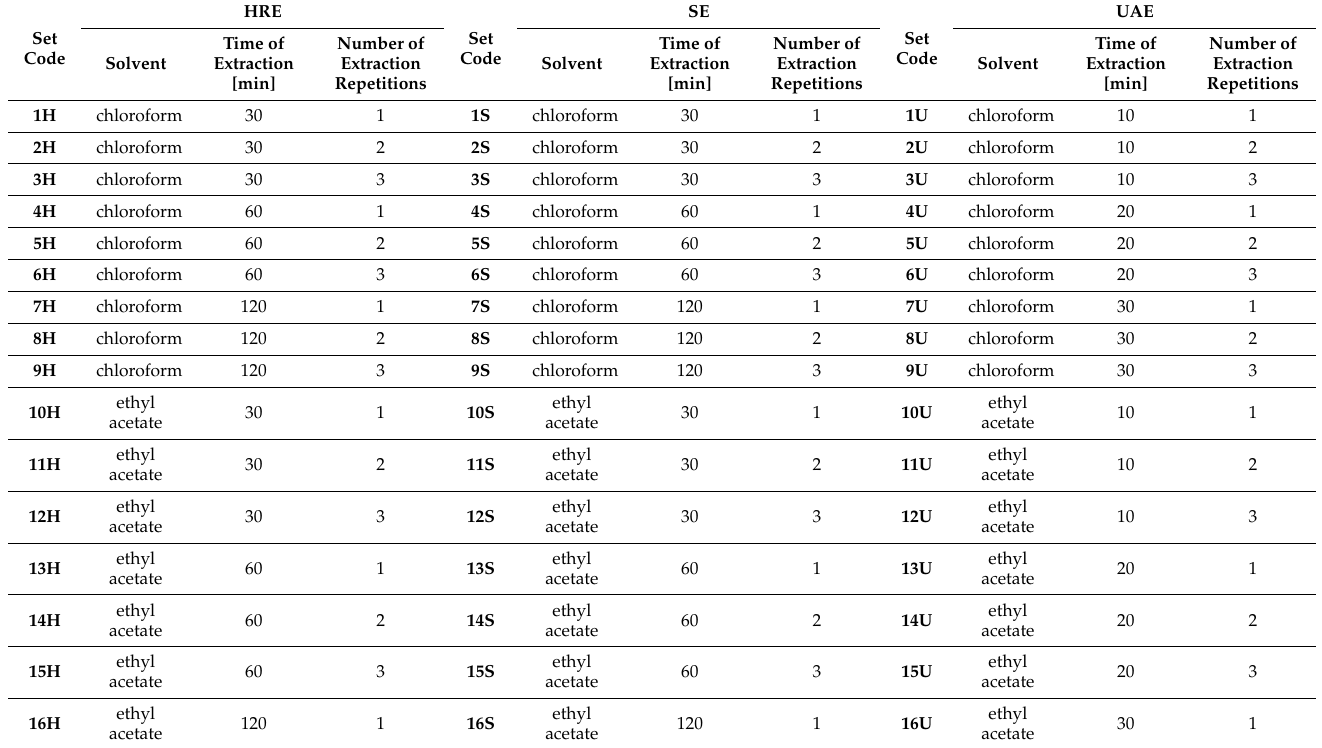
Table 1. Experimental design and codes for each set of